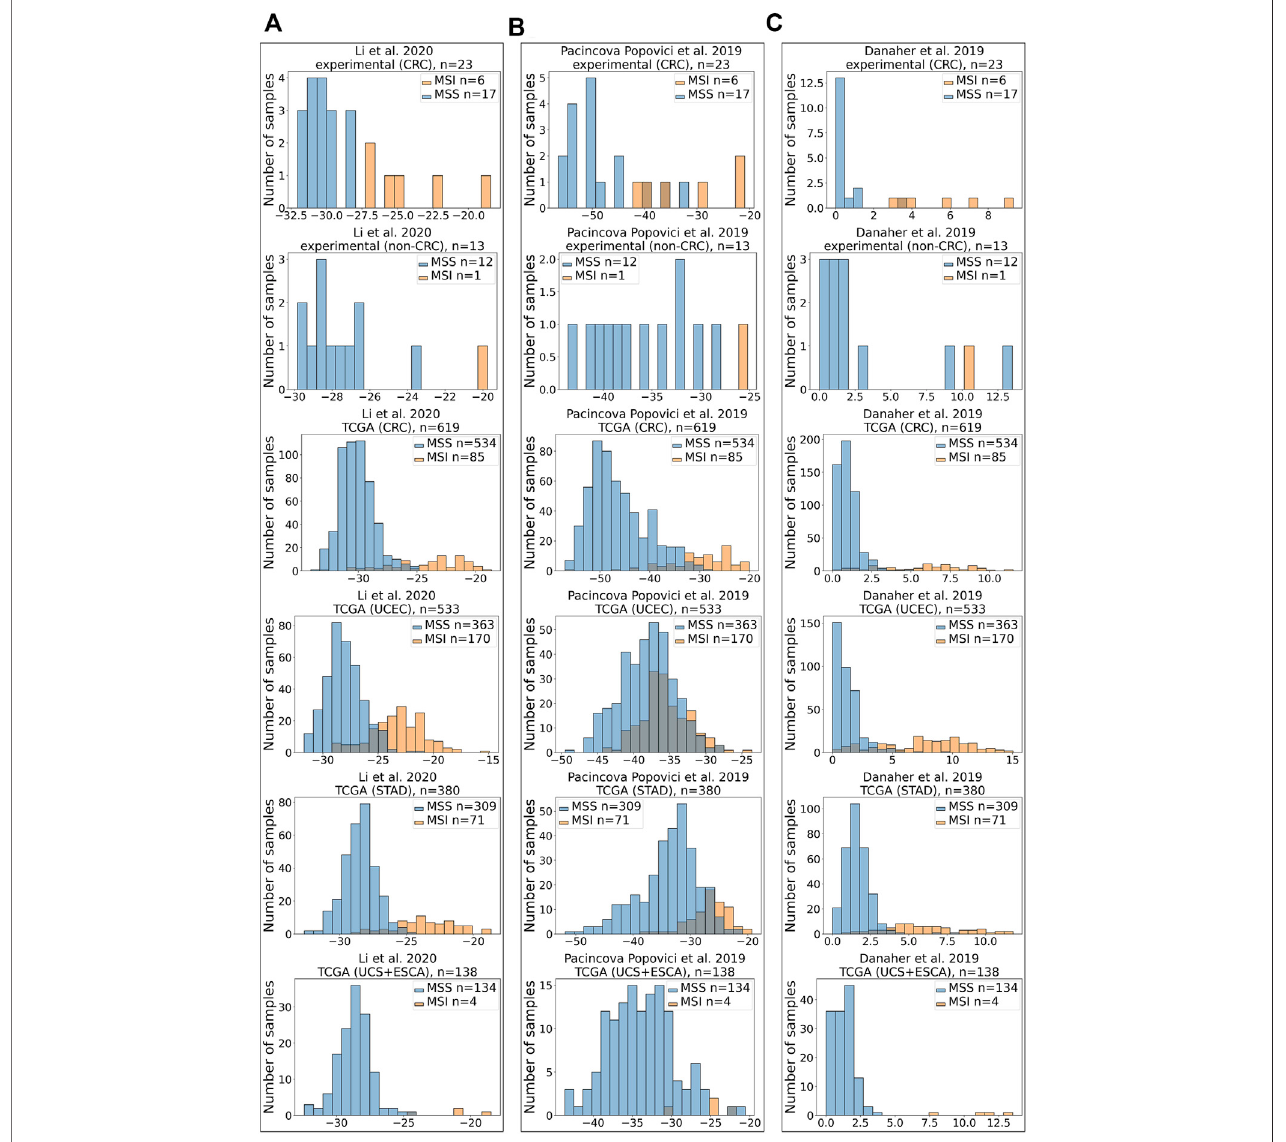
FIGURE 3 | Distribution of scores for MSI RNAseq gene signatures. X-axis shows MSI signature score, Y-axis — number of samples. All signatures were tested for assessmentofMSIstatusonCRC experimental dataset,experimentalnon-CRC(control)dataset,TCGACRCdataset,TCGAUCECdataset,TCGASTADdataset,and joint TCGA UCS + ESCA dataset. Results for Li et al. (2020) (A) , Pa č ínková and Popovici (2019) (B) , and Danaher et al. (2019) (C) gene signatures are